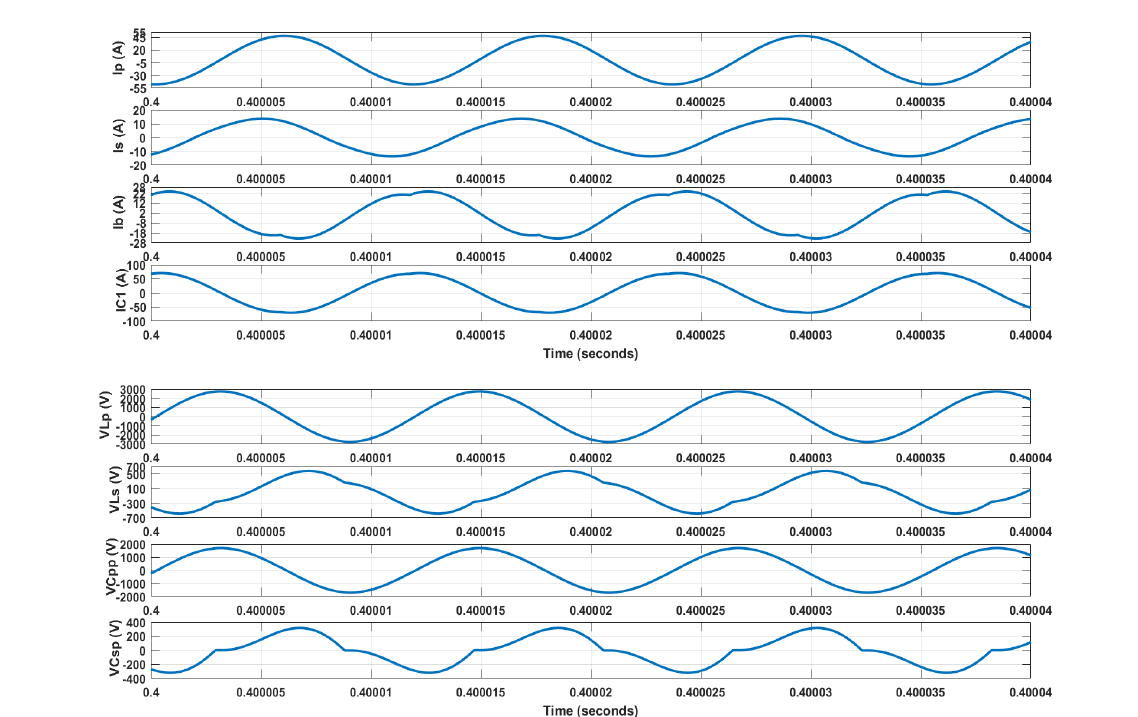
Figure 9. Steady-state voltage and current waveform of various circuit elements.